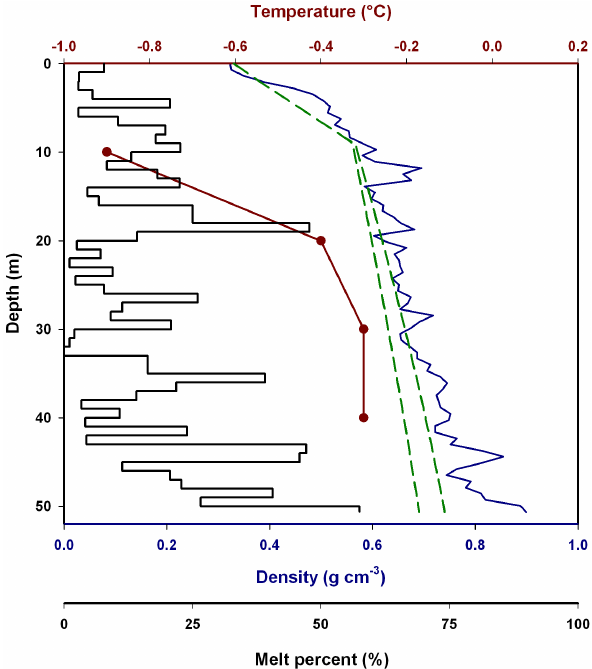
Fig. 3. Density profile (blue), temperature (red) in the borehole at Pío XI glacier, and melt percent (black). The melt percent represents averages over 1 m depth. Green dashed lines show densities simulated with an empirical model of firn densification in the dry firn zone (Herron and Langway, 1980), using a firn temperature of -1°C and an annual accumulation rate of 7.1 m weq (left curve) and 3.4 m weq (right curve), respectively.